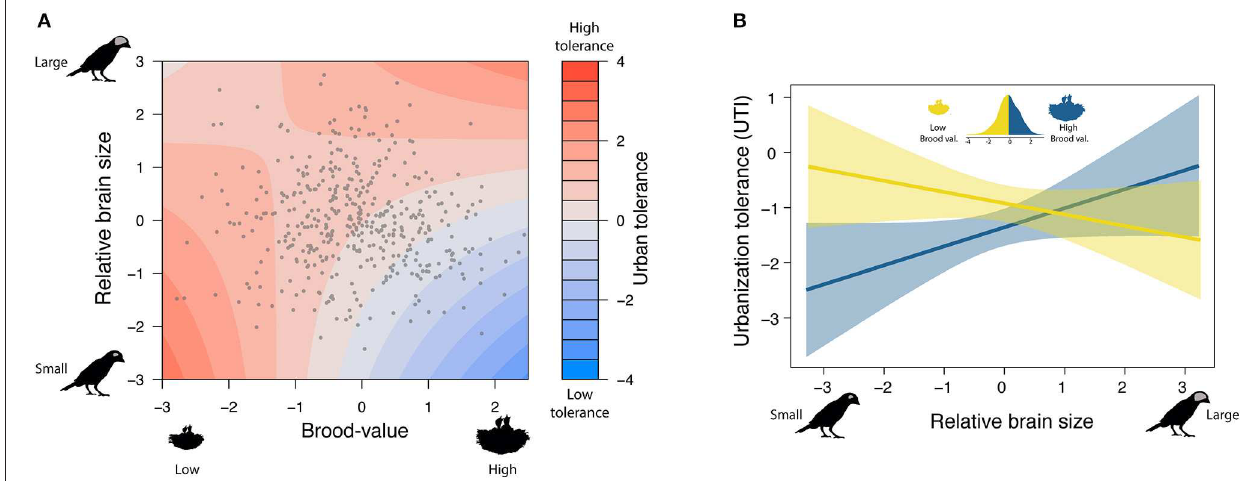
FIGURE 2 | Brain size interacts with brood value to predict urban tolerance. (A) Either species with lower brood values and small brains (bottom-left) or species with high brood values and big brains (up-right) are able to tolerate urban environments. (B) Splitting species into those investing in few breeding attempts (High brood value) or many attempts (Low brood value), helps to visualize the interaction: Brain size increases urban tolerance in species with high brood value but not in species with low brood value.